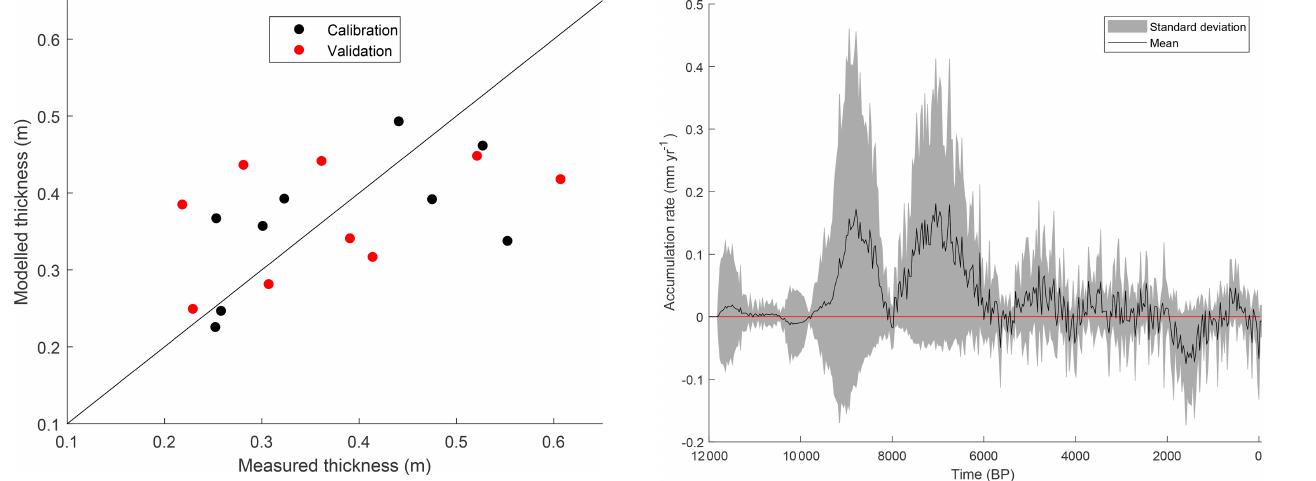
Figure 8. Simulated mean peat accumulation rate and standard de- viation for all grid